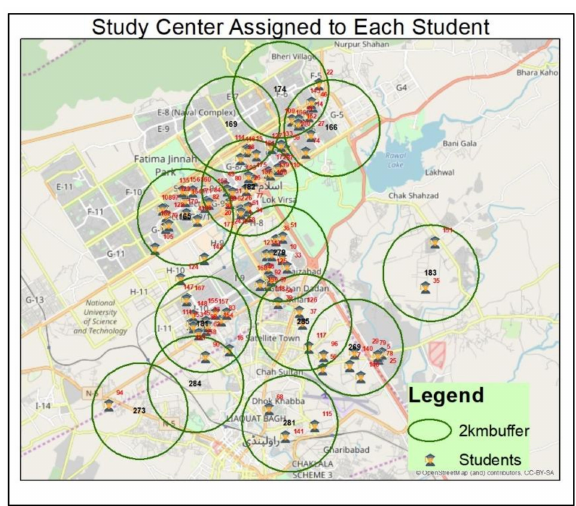
Figure 6. Study center allocation.